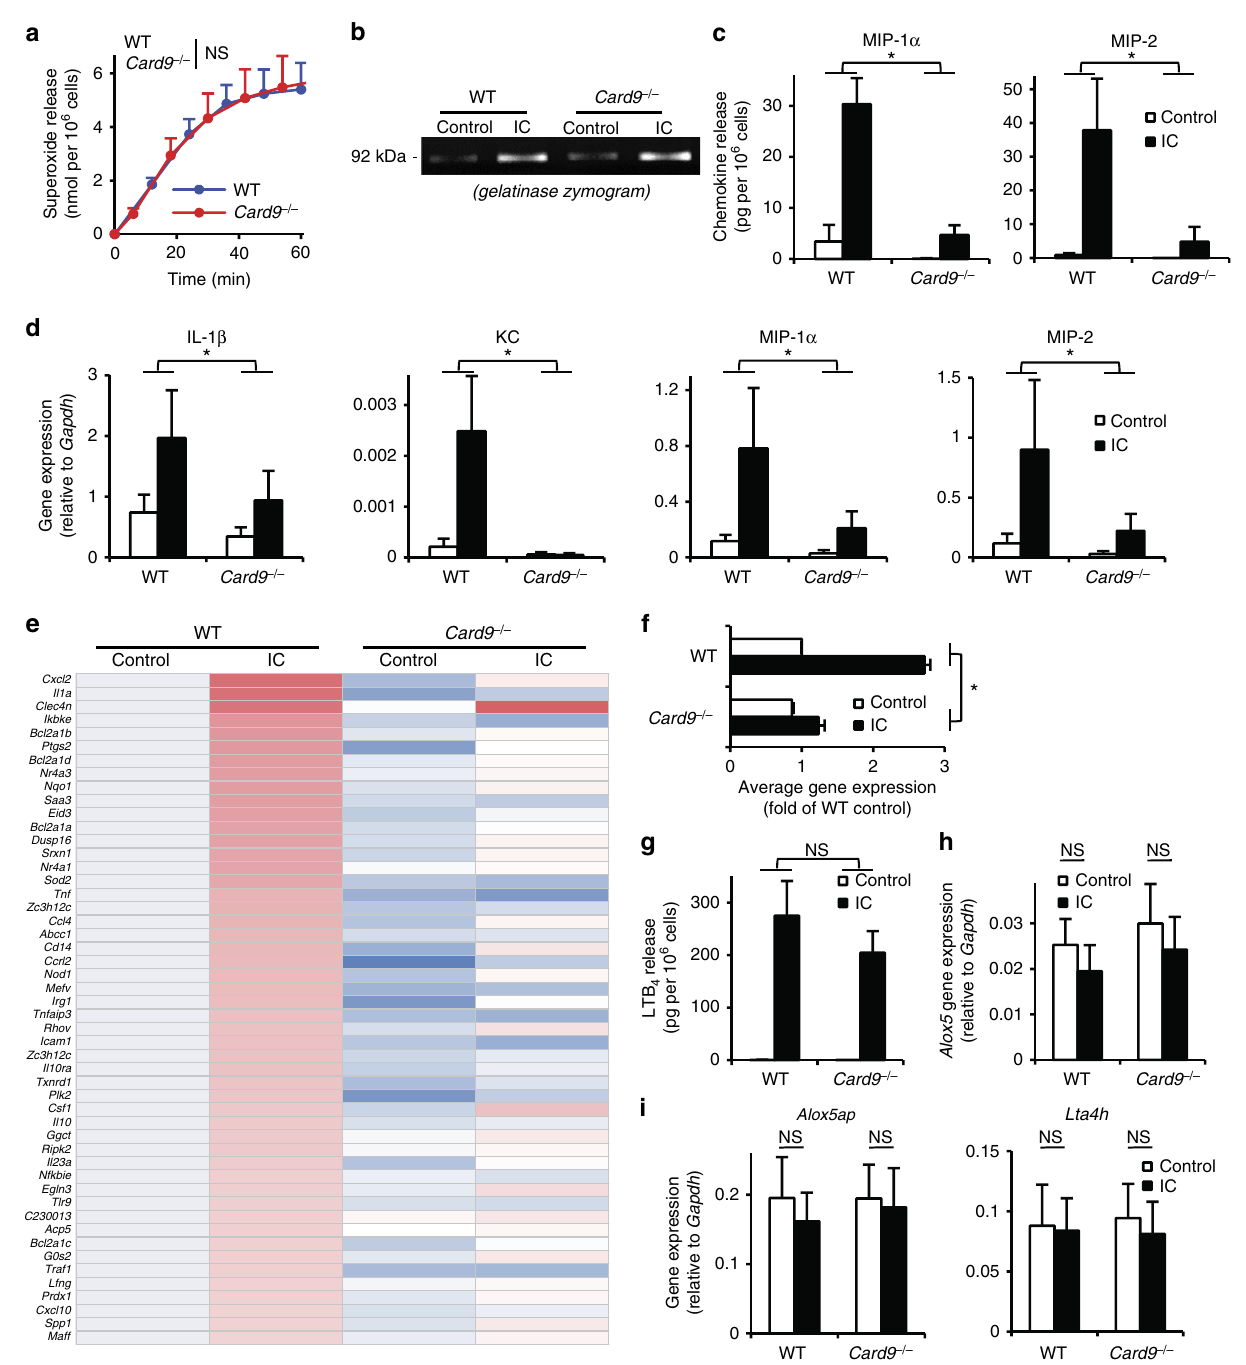
Figure 6 | CARD9 is required for neutrophil gene expression changes and chemokine/cytokine release. Wild type (WT) and Card9 (cid:2) / (cid:2) neutrophils were placed on immobilized immune complex (IC) surfaces. Superoxide release ( a ) was followed by a spectrophotometric assay, while gelatinase degranulation was determined by gelatinase zymography ( b ). Cytokine, chemokine and lipid mediator levels in cell-free supernatants were determined after an incubation for 6h (cytokines) or 1h (LTB 4 ) using ELISA assays ( c , g ). Gene expression changes were followed by quantitative PCR ( d , h , i ) or by Affymetrix Microarrays ( e , f ). ( f ) The average changes of the expression of the 50 most highly upregulated genes shown in ( e ). Kinetic curves in a show mean and s.e.m. of six independent experiments. Control data points were subtracted. ( b ) Representative of three independent experiments. Graphs ( c , d , f – i ) show mean and s.e.m. from three to five independent experiments, while the heat map in e represents the colour-coded mean of three independent experiments. * P o 0.05; NS, statistically not significant (two-way ANOVA except for h and i where one-way ANOVA was used); see the text for actual P